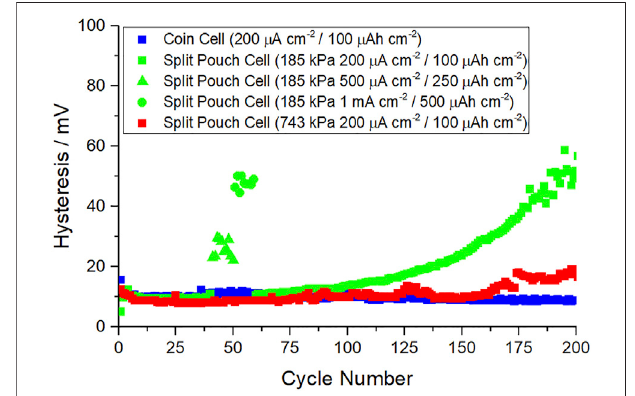
FIGURE5| Na||Cuhalf-cellcyclelifehysteresisincoincellvs.splitpouch cell format at two different applied pressures, 185 and 743